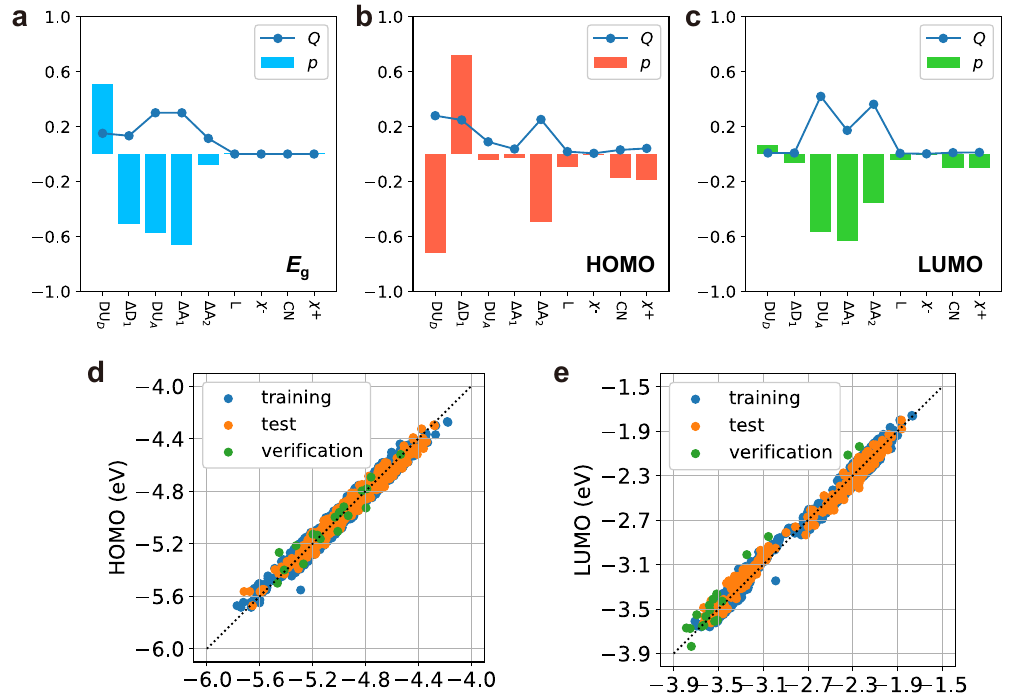
Fig. 6 Prediction of HOMO and LUMO via machine learning. Correlation coef fi cients ( p ) and feature importance ( Q ) as a function of the revised structural features for E g ( a ), HOMO ( b ) and LUMO ( c ) levels. The comparisons between the DFT and the machine learning results for HOMO ( d ) and LUMO ( e ) levels,